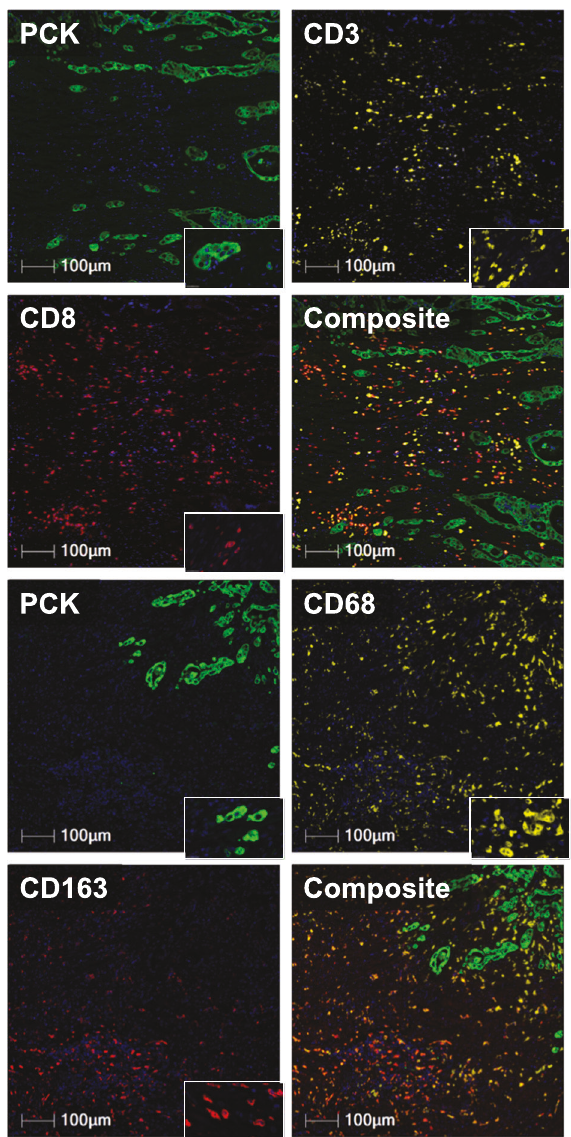
Fig. 1 Multiplex immuno fl uorescence of the tumor cells, tumor in fi ltrating lymphocytes, and macrophages. Tumor cells are shown in green, CD3 + and CD68 + cells in yellow, CD8 + and CD163 + in red. Composite images for both slides are